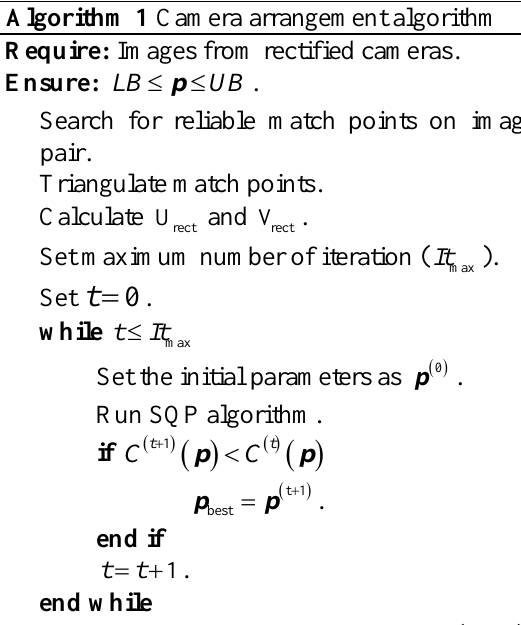
Algorithm 1 Camera arrangement